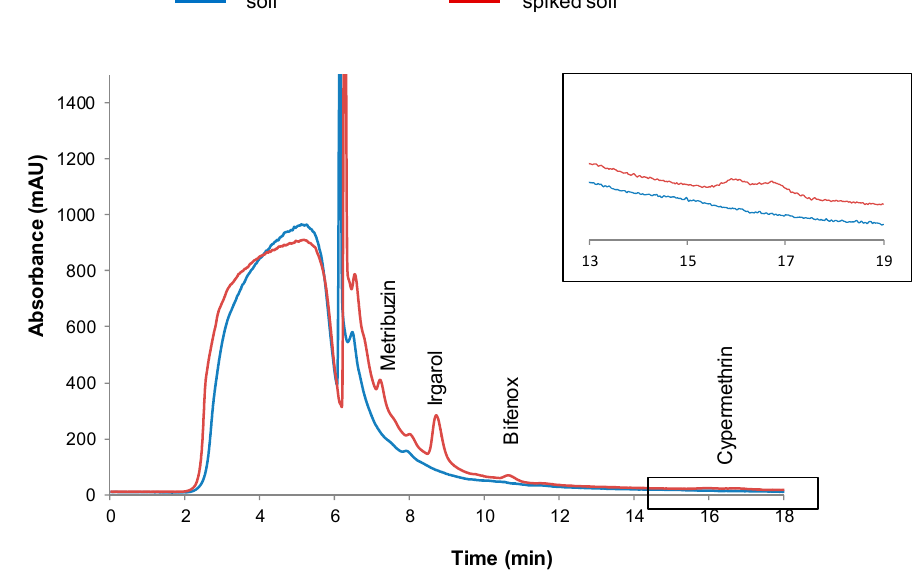
Figure 4. Chromatograms obtained under the proposed conditions for the extract obtained from a soil sample and the same sample spiked with metribuzin, irgarol, bifenox (25 ng/g), and cypermethrin (40 ng/g).